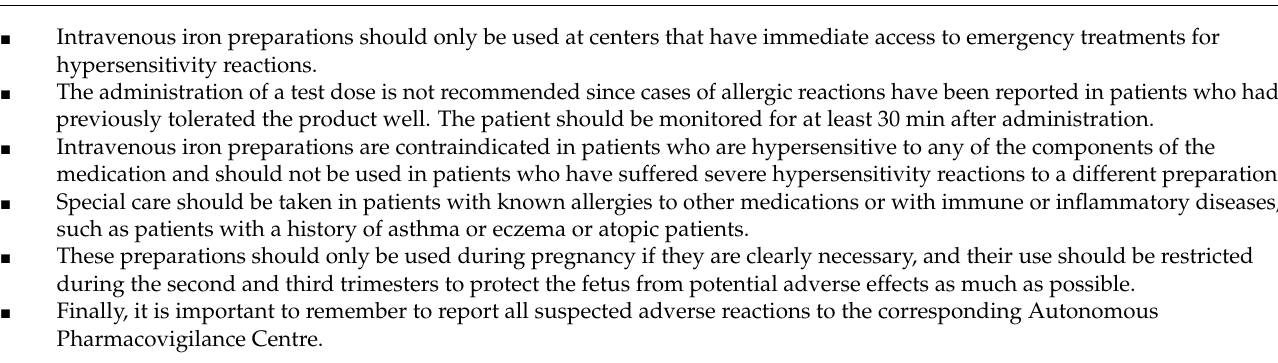
Table 6. Recommendations for the administration of intravenous iron.